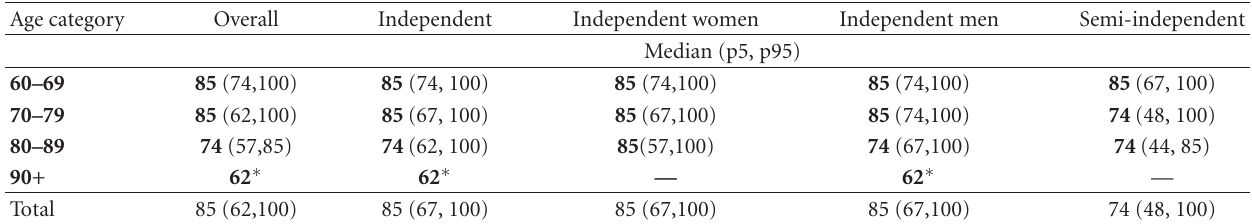
Table 3: DEMMI reference intervals for individual comparisons, median (5th, 95th percentiles). Please refer to Table 2 for subsample sizes.